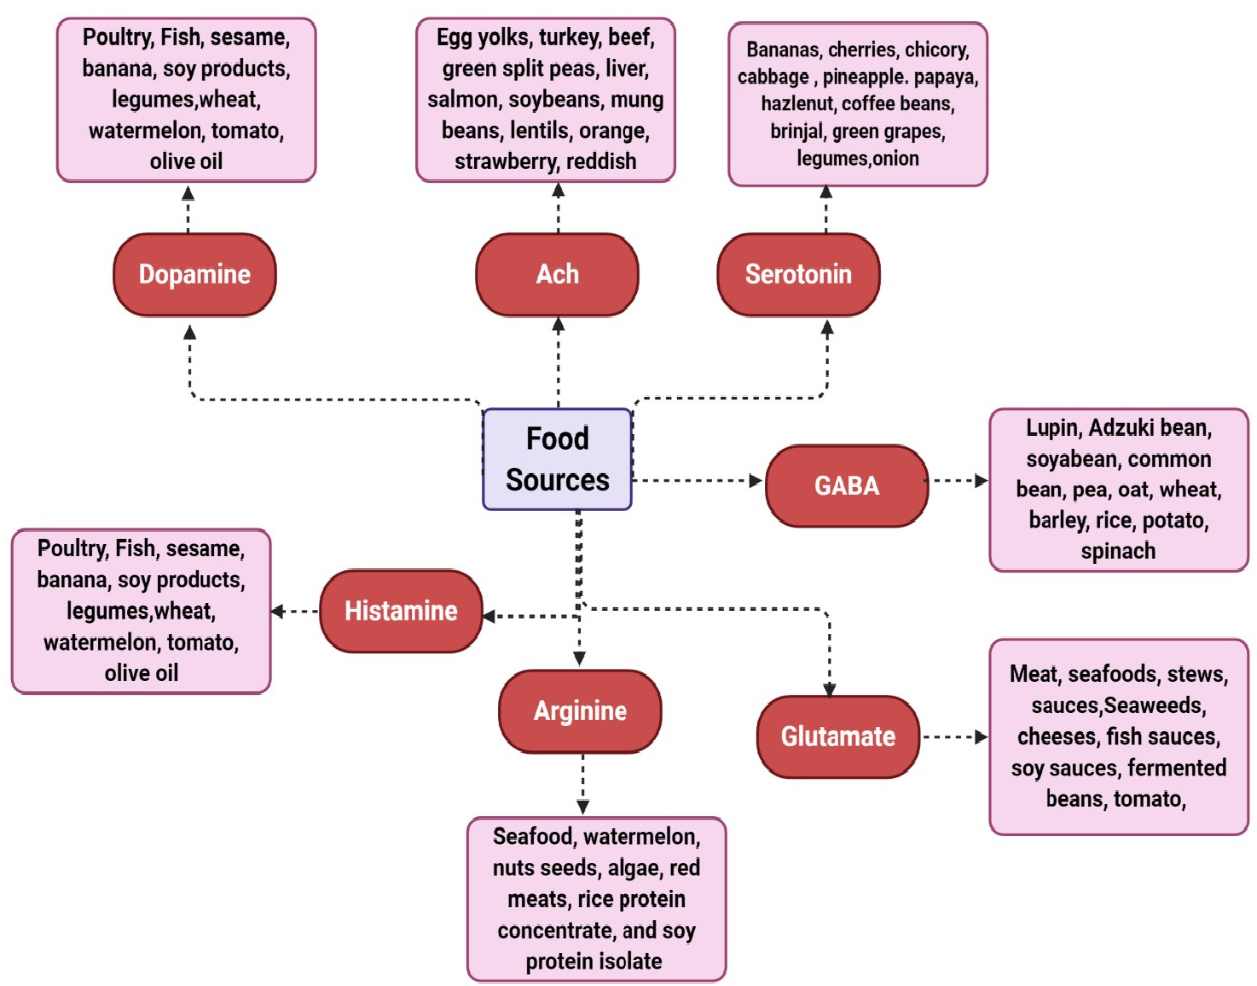
Figure 5. Major NTs and their related food